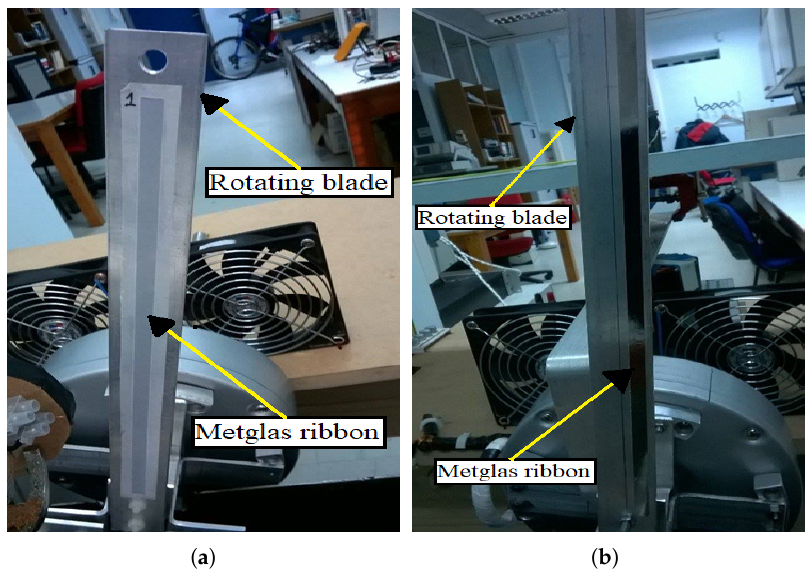
Figure 2. ( a ) A piece of a Metglas 2826MB ribbon attached to a rotating blade with double-sided tape. ( b ) The same rotating blade with the excess tape was stripped thoroughly using a strong plastic blade to prevent the beam from scratching. Table 2. Physical properties of 3M TM VHB TM 4930 double-sided tape. Sr. No.